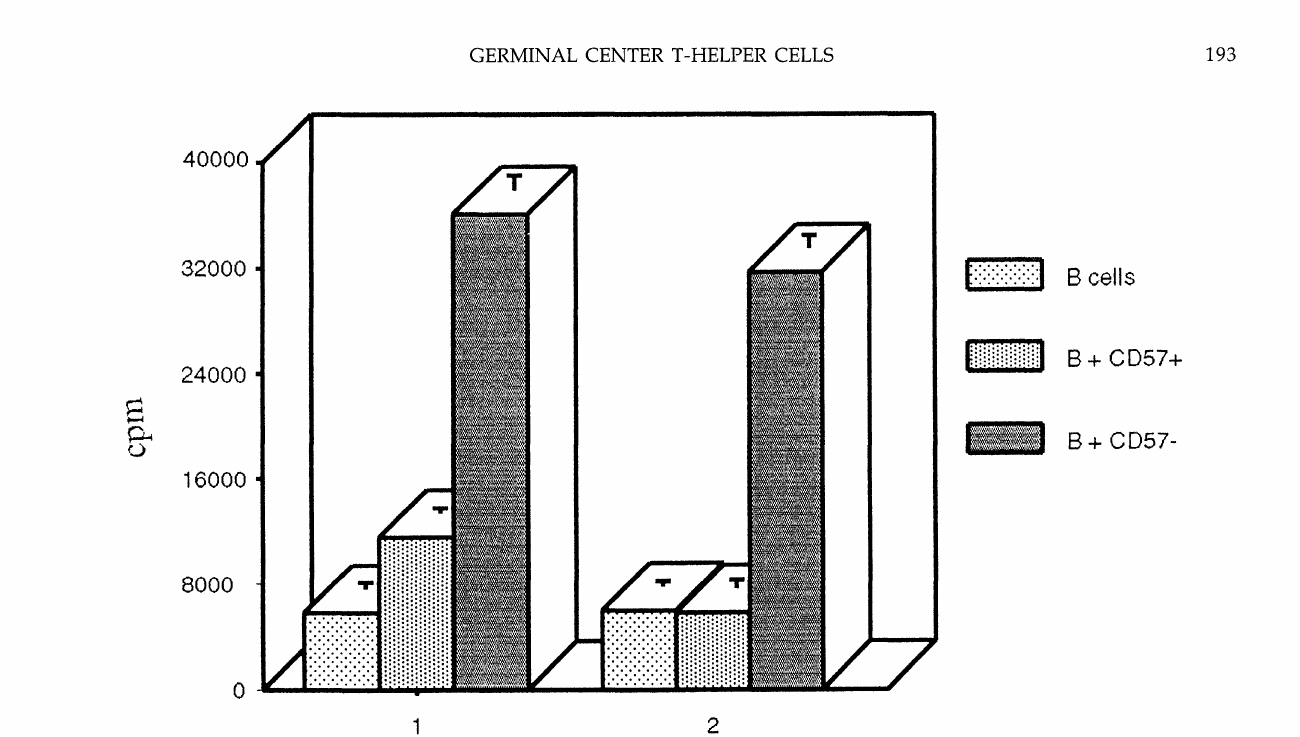
FIGURE 4. Effect of CD57 or CD57- cells on the proliferation of preactivated B cell. B cells (105 cells) were preactivated with: 1:SAC (at a final dilution of 1/10,000) or 2: anti-Ig combined to anti-CD40 (respectively at 1/600 and 100 ng/ml). After 24 hours of culture, mitomycin-C-treated CD57- or CD57 cells (3 x 105 cells/well) were added in presence of PHA (2 lag/ml). Thymidin incorporation by B cells was measured after 48 hours. Results are expressed as the mean of quadriplicate cultures and are representative of 5